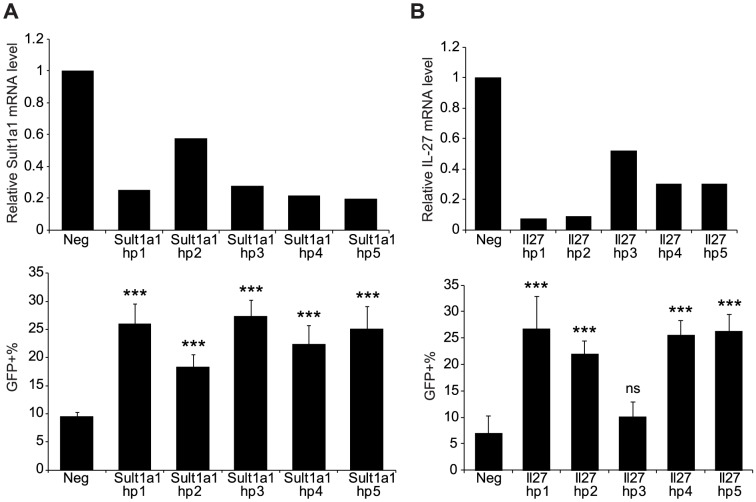
The relative expression level of candidate genes is correlated with observed antiviral phenotype.Upper panels: mRNA expression of Sult1a1
(A) and Il27
(B) in irrelevant shRNA-transduced cells compared to shRNAs against the indicated gene measured by qRT-PCR. Gapdh was used as internal control for normalization. The results shown are the average from two independent experiments. Lower panels: percentages of GFP-positive cells after HSV-GFP infection in cells previously transduced with irrelevant shRNA (lacZ and luciferase) or targeting shRNA for Sult1a1
(A) or Il27
(B). Data shown are representative of 3 independent experiments. ns, not significant; ***P<0.001 compared to negative control by one-way ANOVA with Dunnett's post-test.